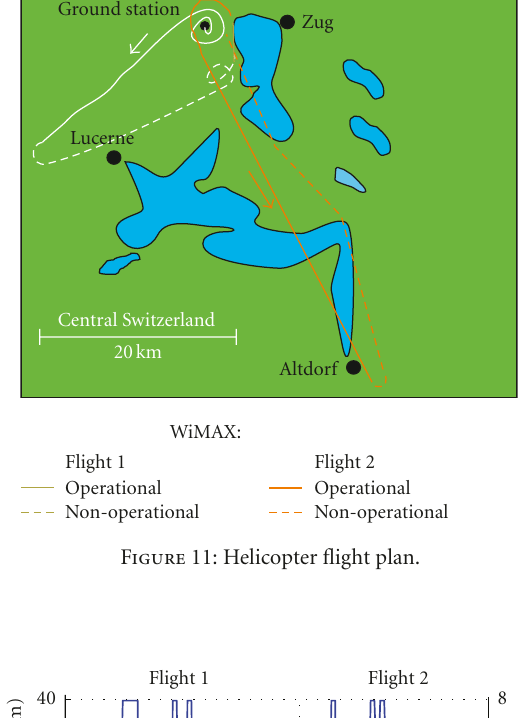
Figure 11: Helicopter flight plan.